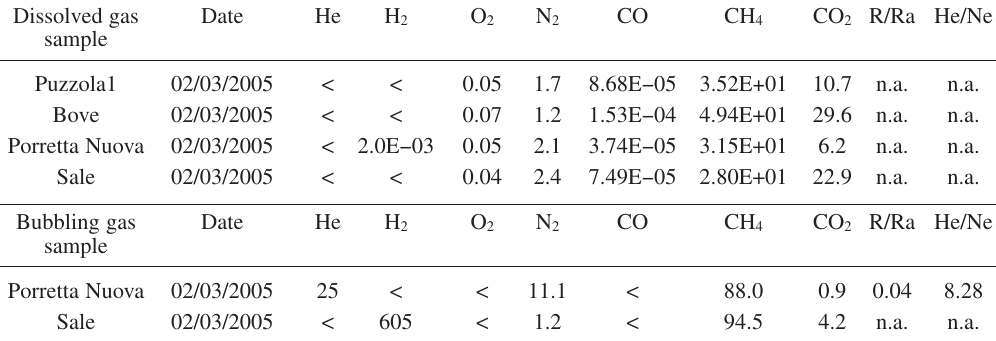
Table II. Analytical results for dissolved and bubbling gases. Dissolved gas data in cc/STP per litre; bubbling gas data in vol% for O 2 , N 2 , CH 4 and CO 2 , in ppm for He and H 2 . Dissolved gas